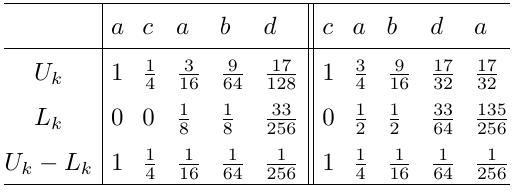
Table 2. Upper and lower bounds on the current interval on the number